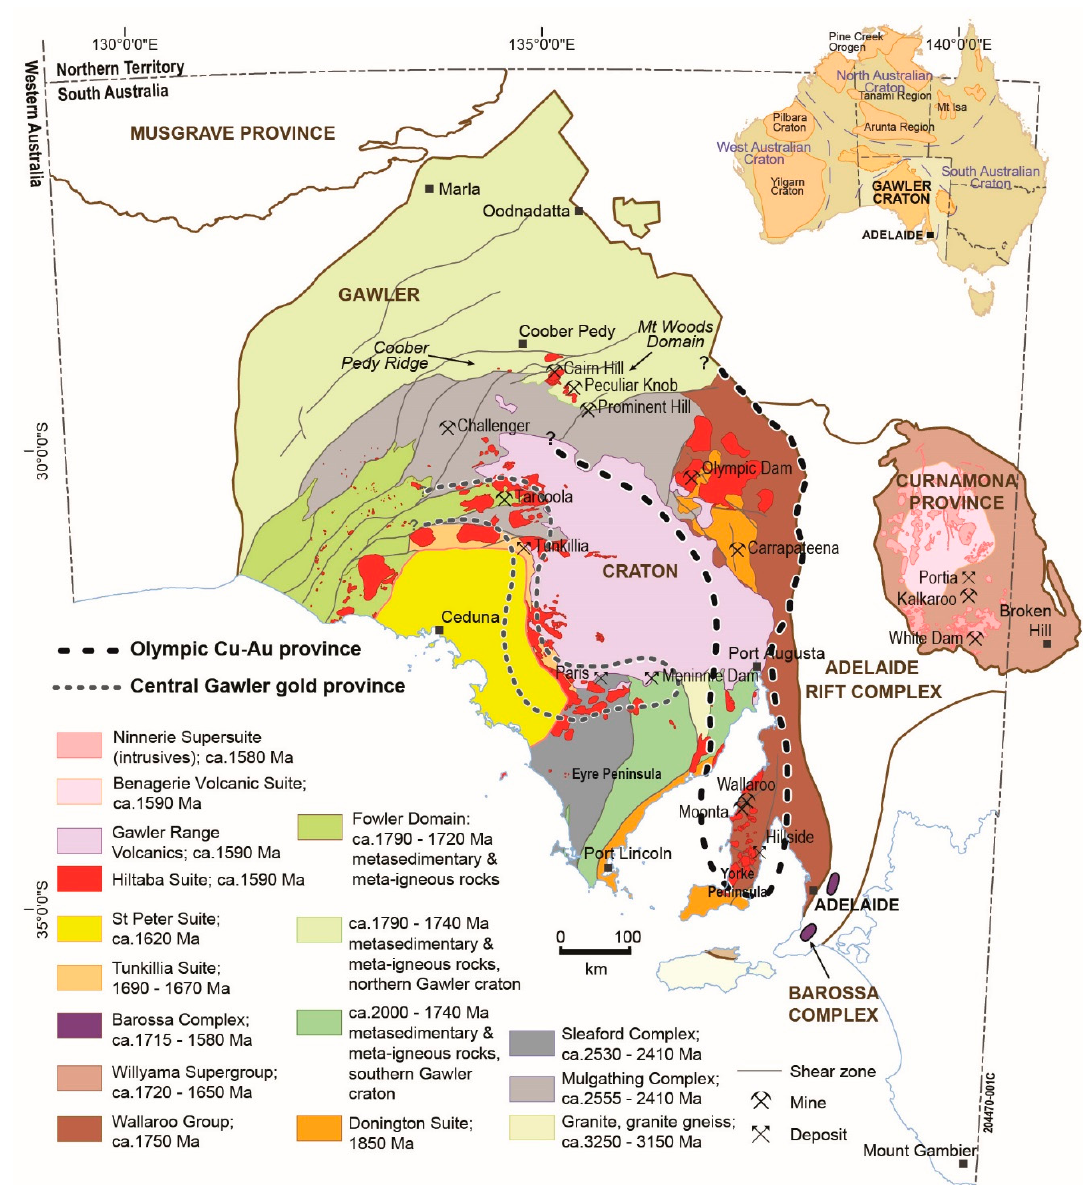
Figure 1. The Olympic Cu-Au Province in the context of the geology of southern Australia. The main lithotectonic units of the Gawler Craton and Curnamona Province are shown and are interpreted from surface observation and geophysical data. The Olympic Cu-Au Province occurs in the eastern Gawler Craton and also indicated is the Central Gawler Gold Province, a gold-dominated metallogenic province formed during the same early Mesoproterozoic tectonic event that formed the Olympic Cu-Au Province. Inset shows the location of the Gawler Craton and Curnamona Province in the context of major Archean and Proterozoic terranes of Australia. Modified from [64].